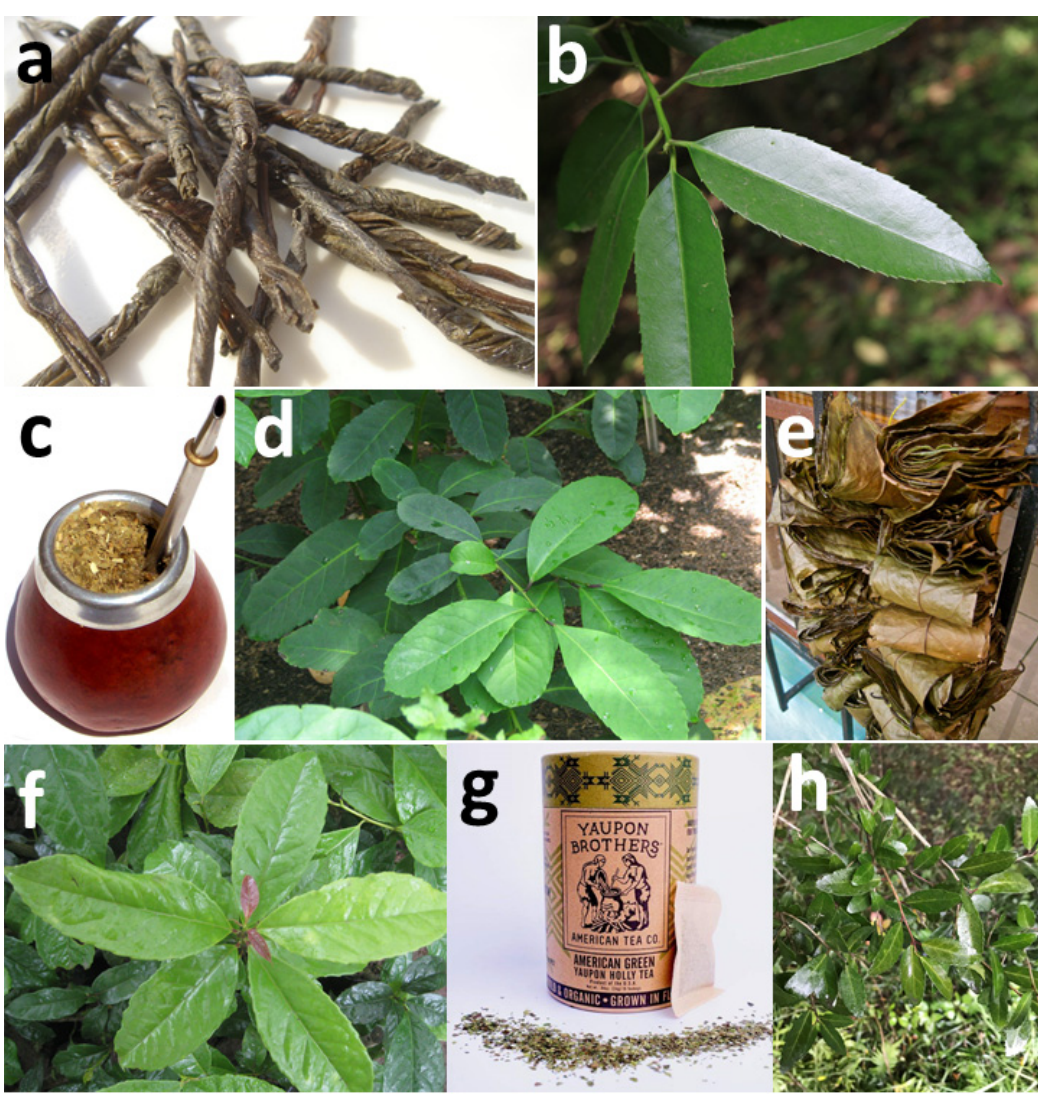
Figure 1. Holly beverages in China—( a ) kudingcha and ( b ) one of its source plants Ilex latifolia ; South America—yerba maté ( c ) and guayusa ( e ) and their source plants I. paraguariensis ( d ) and I. guayusa ( f ); and the United States—yaupon ( g ) and its source plant I. vomitoria ( h ). Photographs from Wikimedia Commons by Sjschen ( a ); Jorge Alfonso Hernández ( c ); Phyzome ( d ); Anna Premo ( e , f ) and Bryon White in the Yaupon Brothers American Tea Co. ( g ). Table 1. Xanthine (caffeine, theobromine, and theophylline) contents in source plants of different holly beverages. ND means no detection; NQA means no quantifiable amount. All these contents were calculated based on 1 g dry weight. Note that several early reports of caffeine content have not been confirmed by subsequent studies with improved techniques and are not included